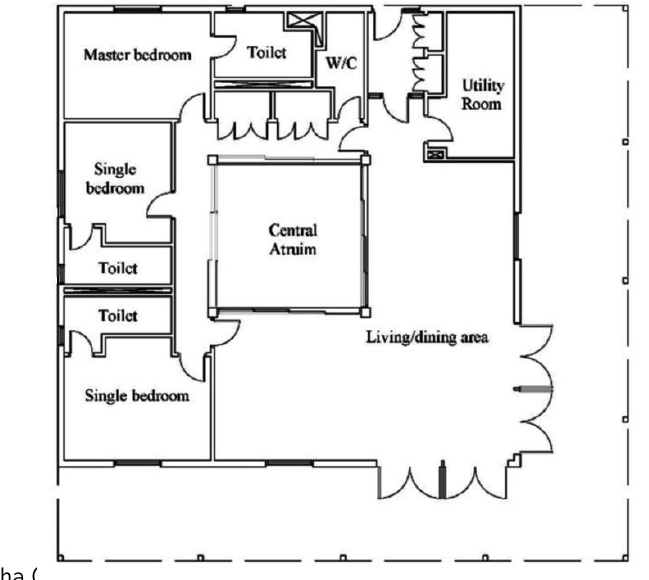
Figure 3 Error! Reference source not found. ). The design of the villas respected the traditional architecture of the region through three main aspects; (a) a central courtyard, (b) a colonnaded patio and (c) the provision of motif movable panels around the courtyard that visually restricted the view towards the private section of the